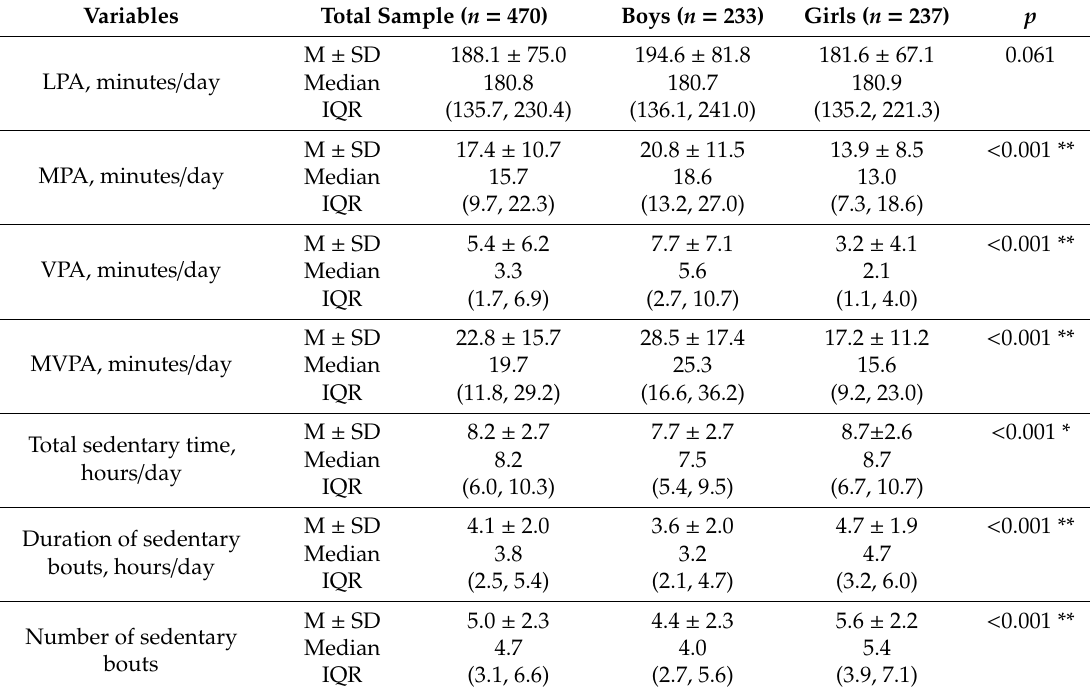
Table 2. Time spent in objectively measured PA and SB patterns in adolescents in a 7-day period.